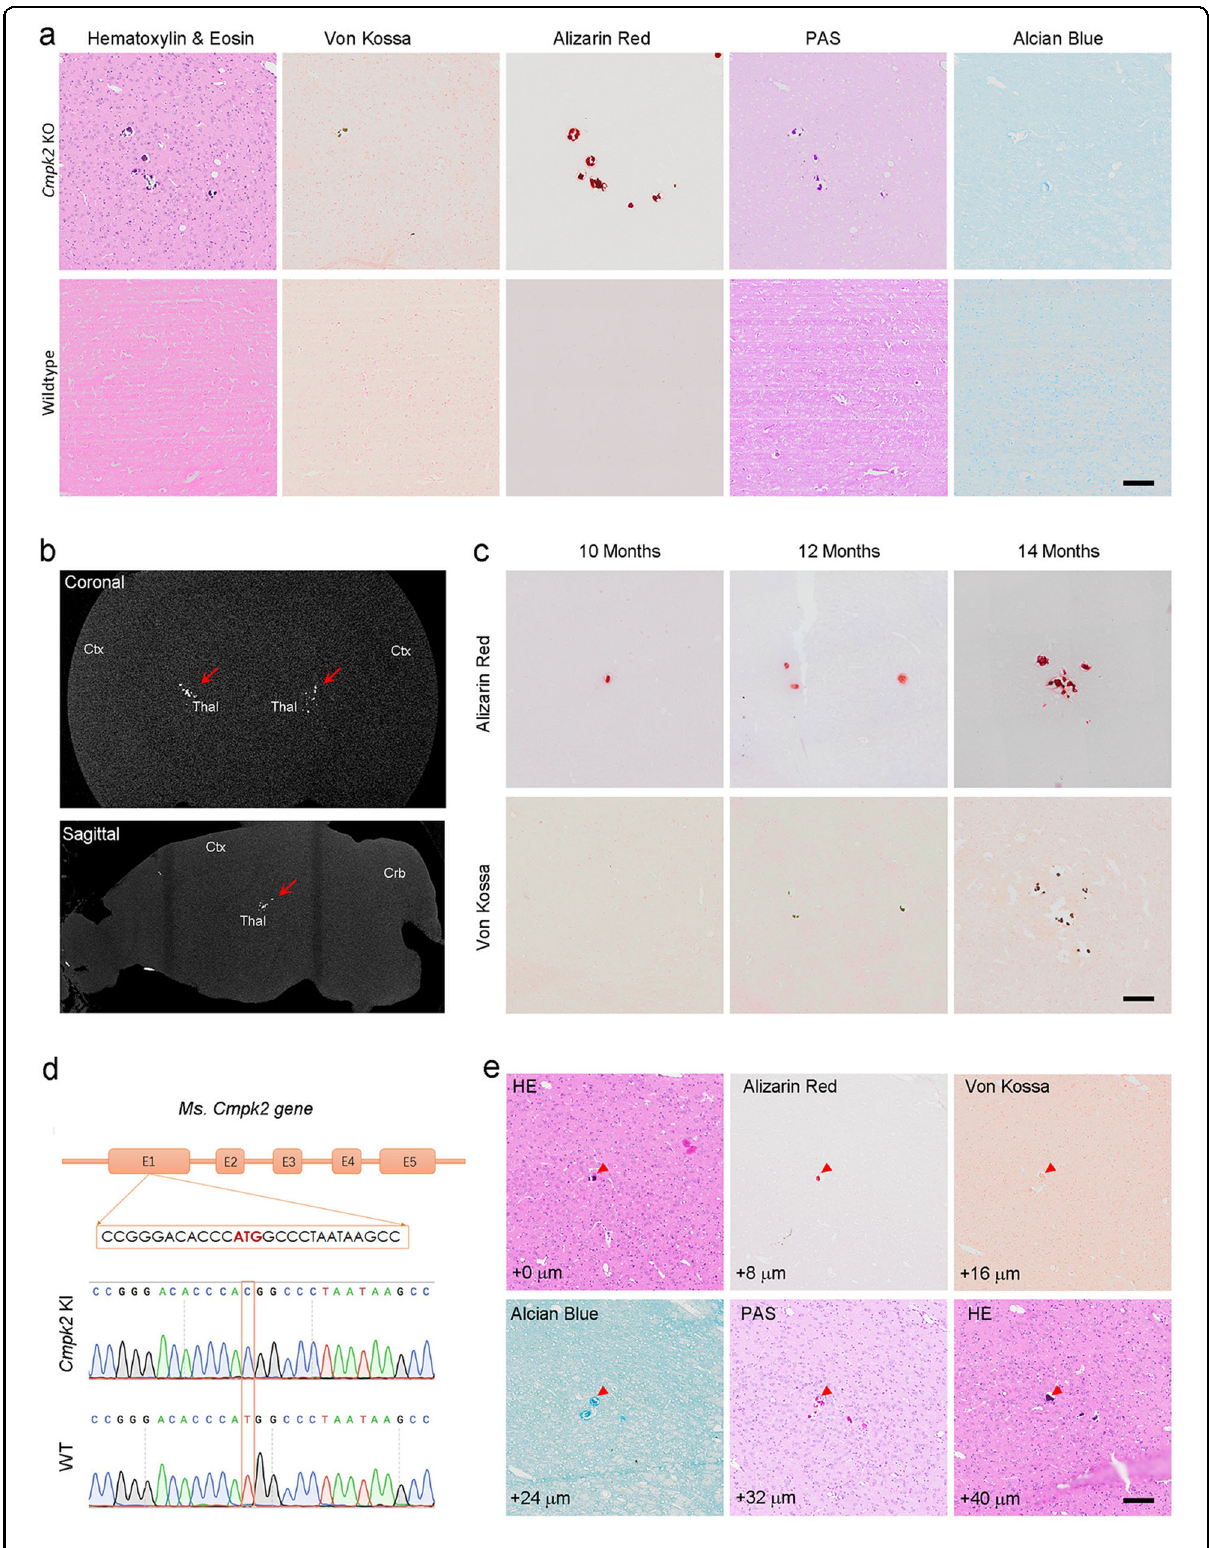
Fig. 5 (See legend on next